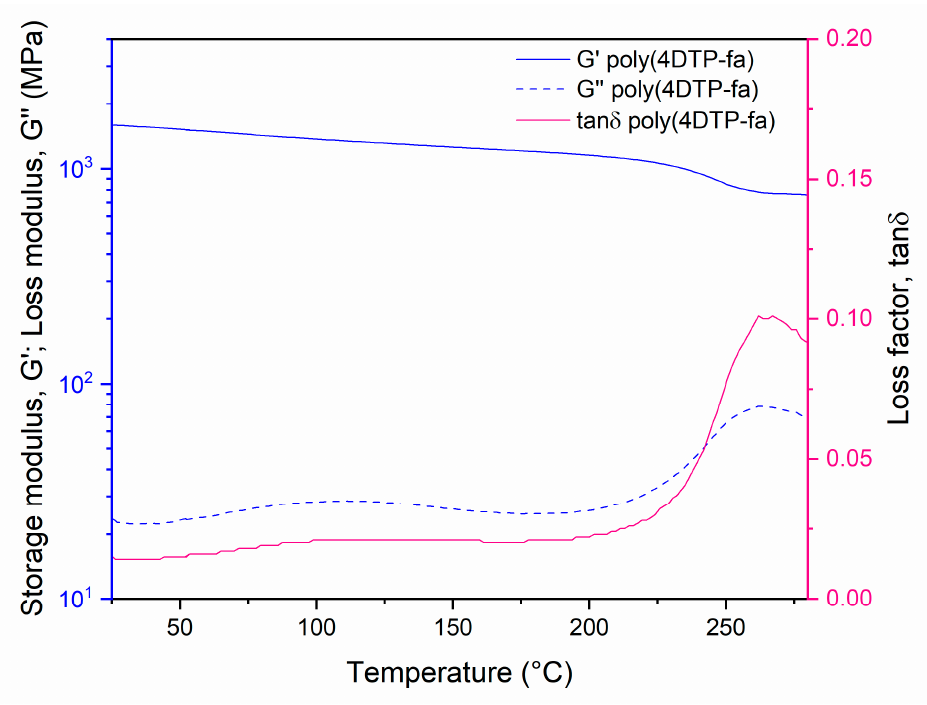
Figure A21. Rheology temperature sweep curves in torsion mode of poly(4DTP-fa).